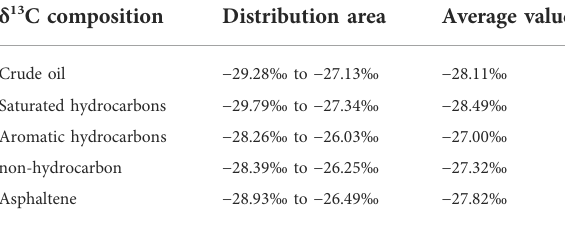
TABLE 2 Carbon isotope distribution of crude oil and group components in Qinnan